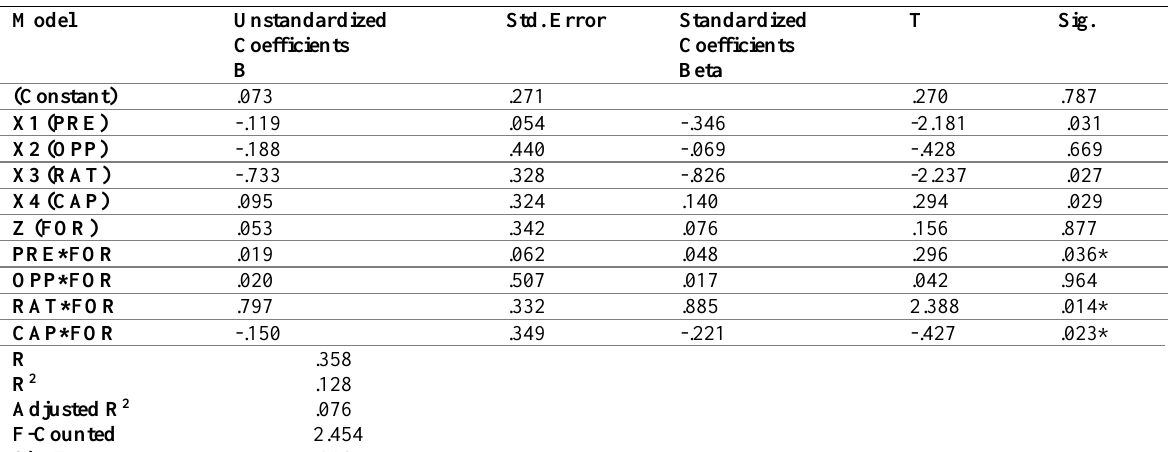
Table 3: Results of the Moderation Regression Analysis